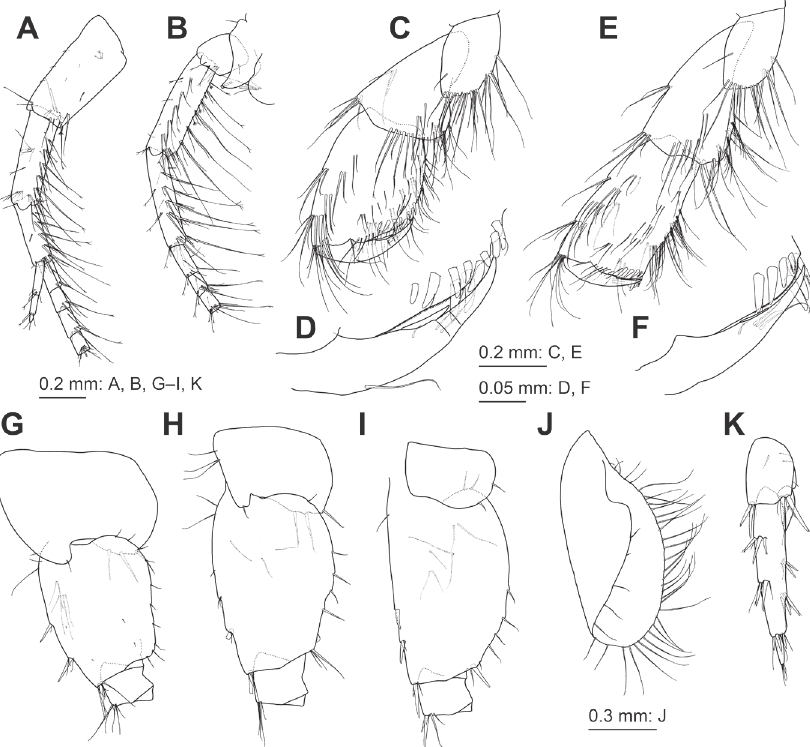
Figure 5. Jesogammarus ( Jesogammarus ) acalceolus sp. nov., female (7.3 mm), NSMT-Cr 29004 A pedun- cular articles 1–3, accessory flagellum, and flagellar articles 1–4 of antenna 1, medial view B peduncular articles 1–5 and flagellar articles 1–3 of antenna 2, medial view C ischium-dactylus of gnathopod 1, medial view D palmar margin of propodus and dactylus of gnathopod 1, medial view, some setae omitted E ischium-dactylus of gnathopod 2, medial view F palmar margin of propodus and dactylus of gnatho- pod 2, medial view, some setae omitted G–I coxa-ischium of pereopods 5–7, respectively, lateral views J brood plate on gnathopod 2, lateral view K uropod 3, ventral setae; dactylus weakly curved, as long as palmar margin. Gnathopod 2 (Fig. 4E, F) with coxa bearing marginal setae ventrally; basis with anterior and posterior margins bearing long setae; length of carpus 1.8 × width, bearing setae on anterior margin; length of propodus 1.1 × carpus and 1.6 × width, respectively, with two clusters of setae on anterior margin, propodus with oblique and weakly convex anterior margin bearing eight medial and five lateral peg-like robust setae; dactylus weakly curved, as long as palmar margin.